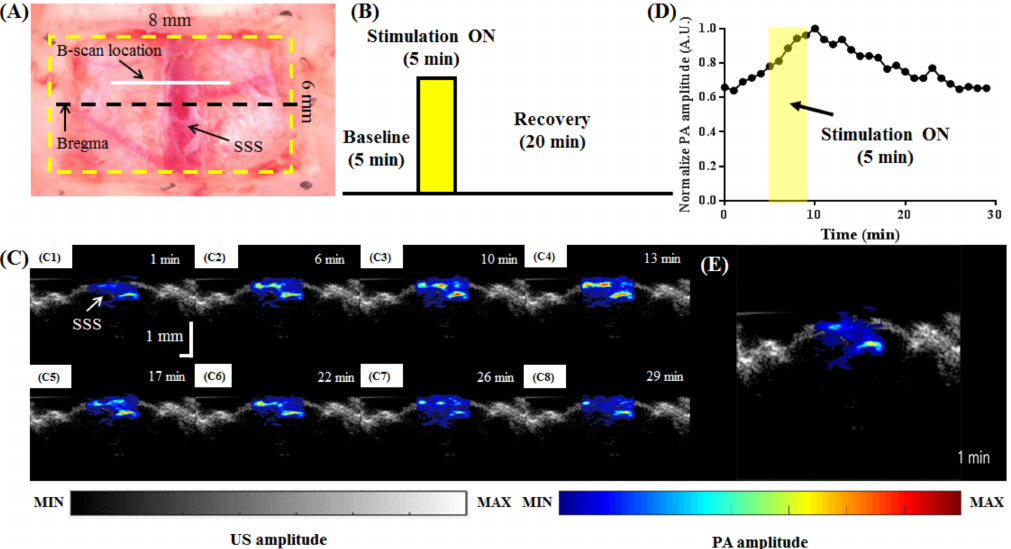
Figure 11. PA B-scan images of the SSS area obtained using an 800 nm excitation wavelength during electrical stimulation of the left forepaw. ( A ) Photograph of the rat brain after a craniotomy was performed for AR-PAM monitoring. ( B ) Schematic of the image acquisition timeline. ( C ) Representative US/PA-overlaid B-scan images obtained before, during, and after stimulation. ( D ) Normalized PA amplitude before, during, and after stimulation. The yellow rectangle indicates the 5 min “Stimulation ON” period. ( E ) Cerebral hemodynamics monitored in the rat brain in real time with 800 nm excitation (Video S5). The PA signal in the SSS region increased during stimulation and decreased after turning the stimulation off.